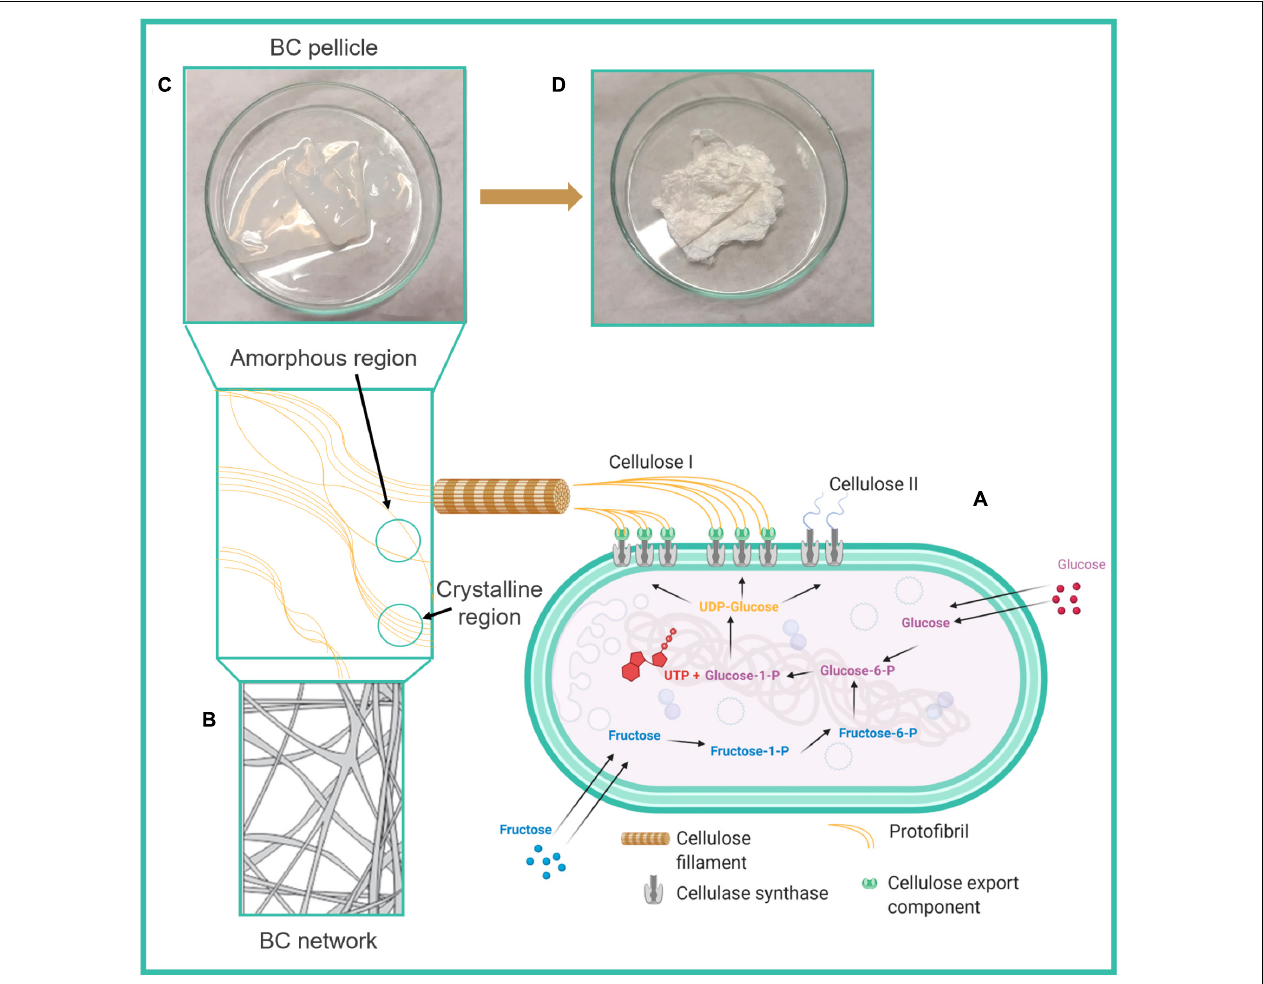
FIGURE 1 | Schematic diagram of (A) the biosynthesis of bacterial cellulose (BC) from sugars, (B) 3D structure of BC network containing amorphous and crystalline regions, (C) BC pellicle, (D) dried BC. Reprinted with permission (Swingler et al., 2021) © Creative Commons Attribution License, 2021,